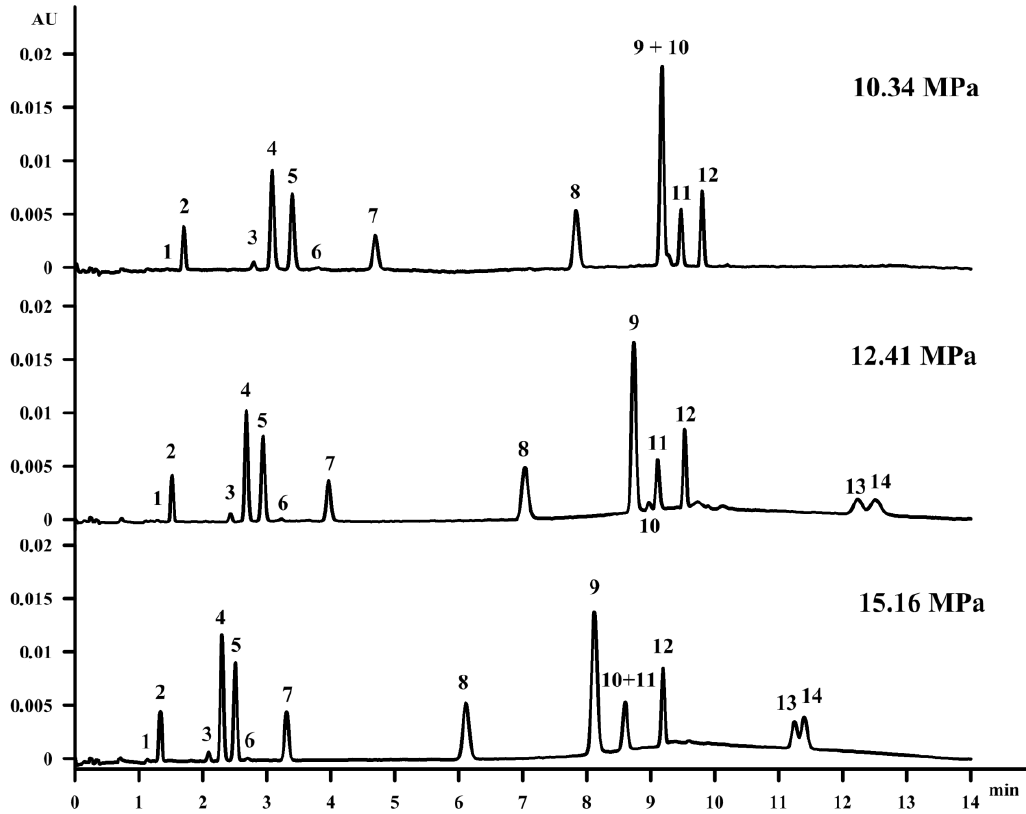
Figure 2. The influence of the back pressure on the separation of fat-soluble vitamins on the Acquity UPC 2 HSS C18 SB column. The elution order is as in Figure 1.